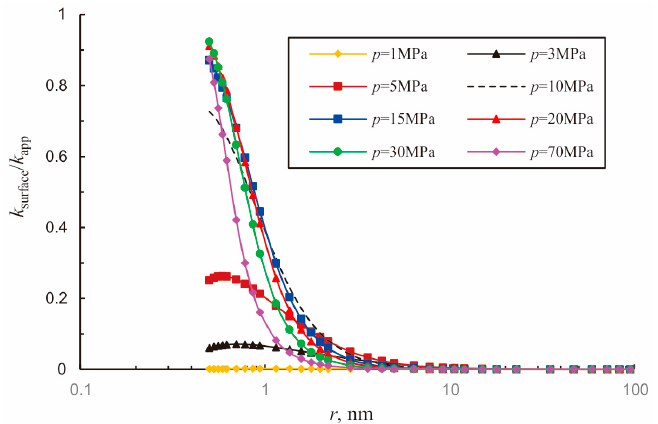
Figure 14. Contribution of surface diffusion to total flux in different conditions.